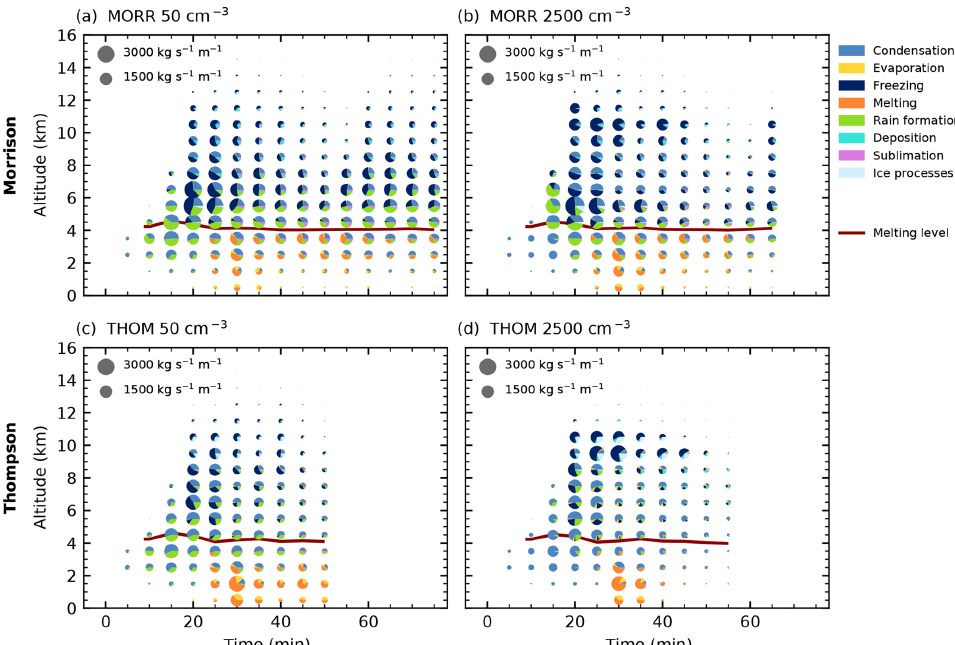
Figure 14. Temporal evolution of the microphysical process rates in CASE2 for the cleanest (a, c) and most polluted (b, d) simulations and the two bulk microphysics schemes (Morrison: a , b , Thompson: c , d ). The pie charts denote the different groups of microphysical process rates with the area proportional to the sum of the microphysical process rates in the specific altitude interval inside the cloud volume.